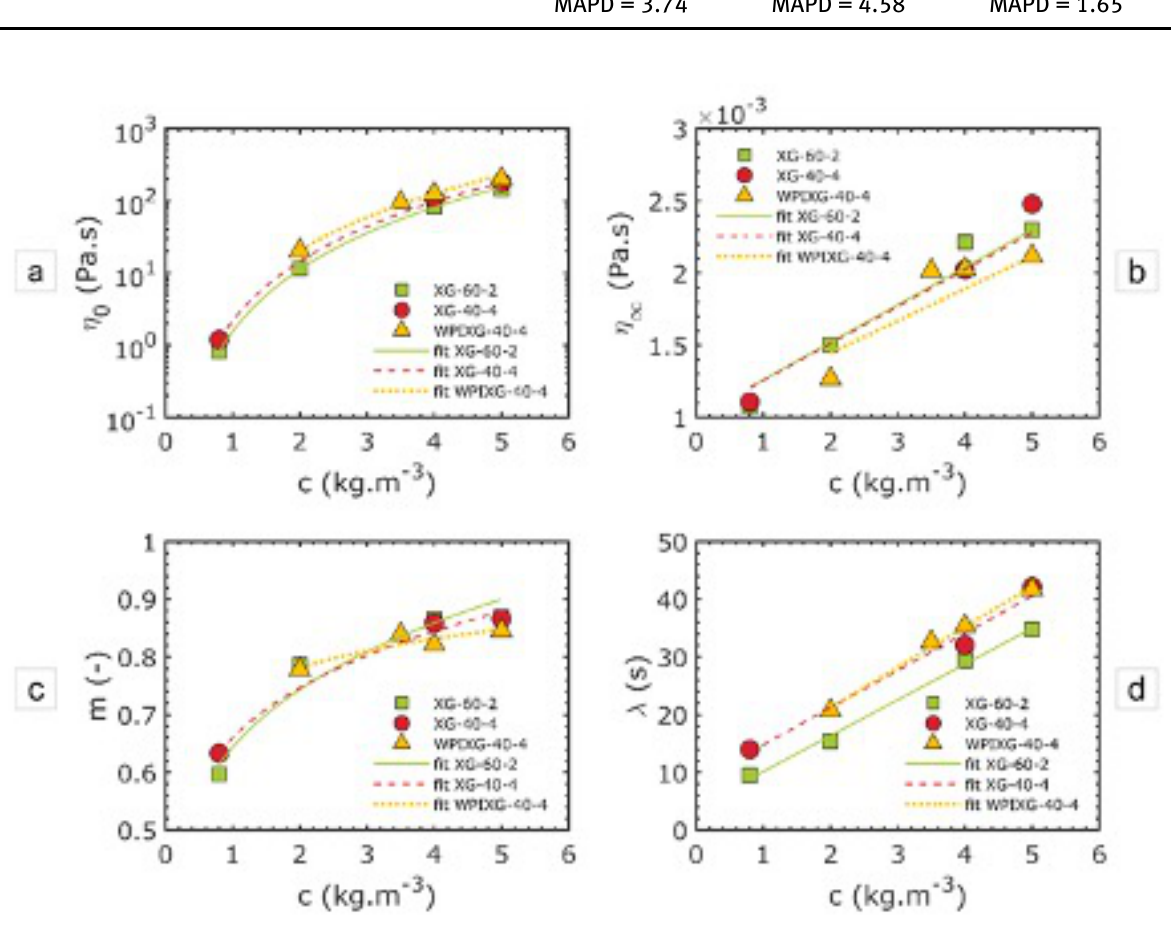
Figure 5: Correlation of the rheological parameters of the Williams-Carreau model with polymer concentration a) zero-shear viscosity ( η 0 ) b) infinite-shear viscosity ( η ∞ ) c) constant related to flow index (m) d) time constant ( λ